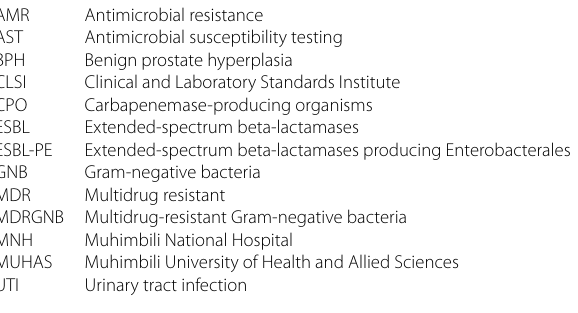
Fig. S2B : A flowchart showing bacterial isolation and identification for Gram-positive bacteria isolated from urine